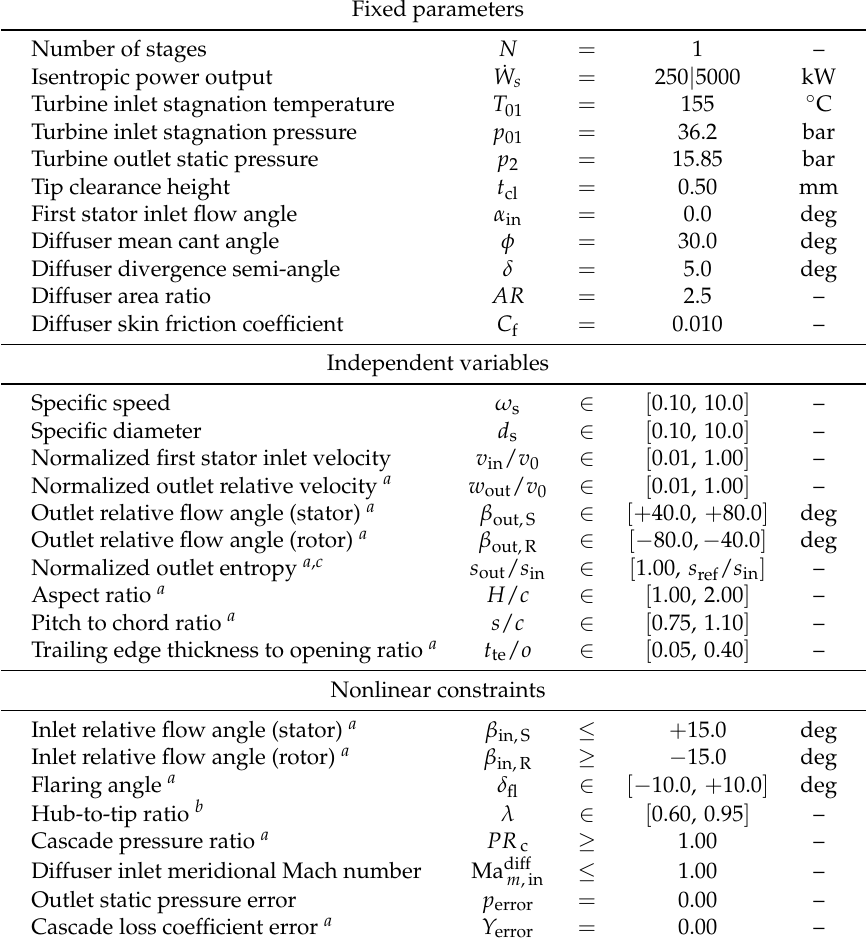
Table 3. Optimization problem formulation and definition of the reference